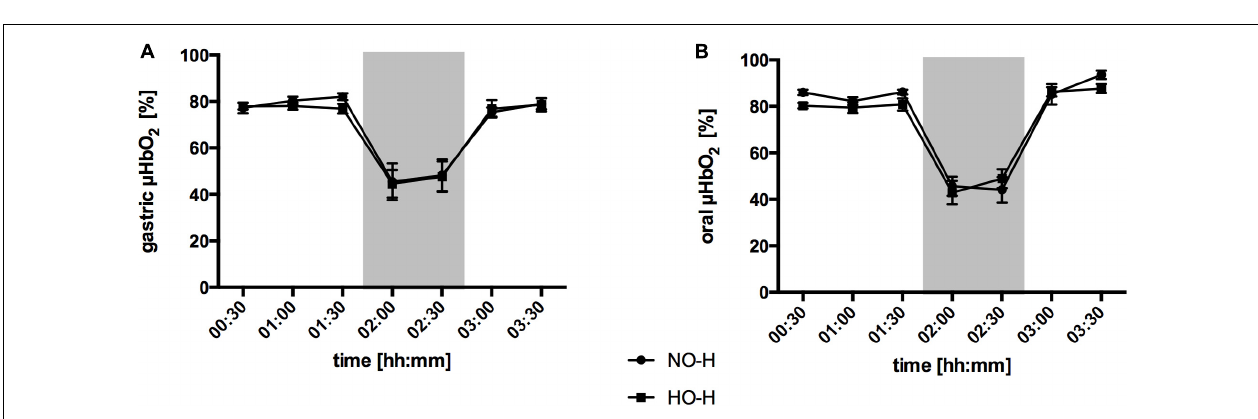
FIGURE 3 | Effect of local carbon dioxide application on microvascular oxygenation: Microvascular oxygenation ( µ HbO 2 ) in percentage (%) at the gastric (A) and oral (B) mucosa under hemorrhagic conditions. The animals received a continuous gas application with either N 2 to maintain local normocapnia (NC-H) or CO 2 for local hypercapnia (HC-H) followed by hemorrhage and retransfusion. One hour of acute hemorrhage is marked gray. Data are presented as mean ± SEM for n = 6 dogs; * p < 0.05 vs. control group (NC-H), 2-way ANOVA for repeated measurements followed by the Bonferroni post-hoc test.